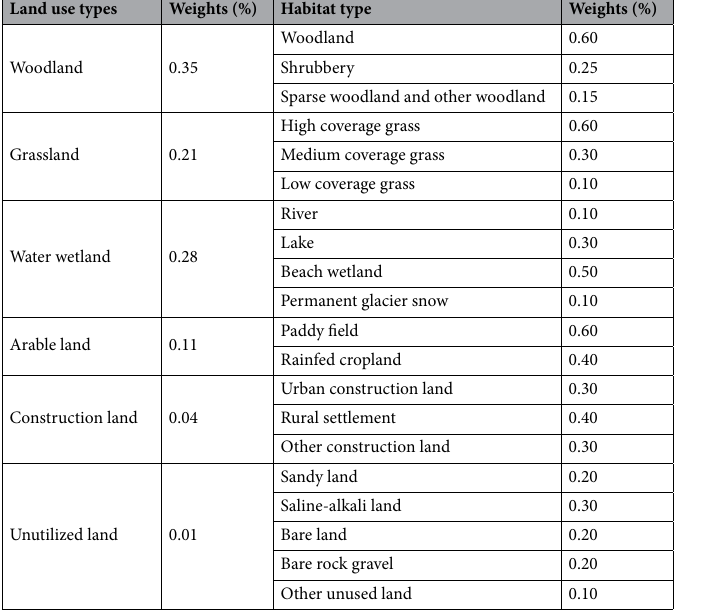
Table 3. Weight of each habitat type in the